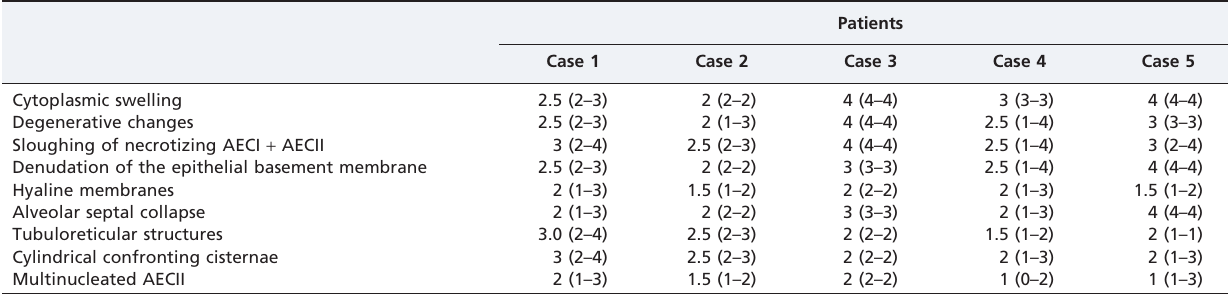
Table 3 - Semiquantitative analysis of electron